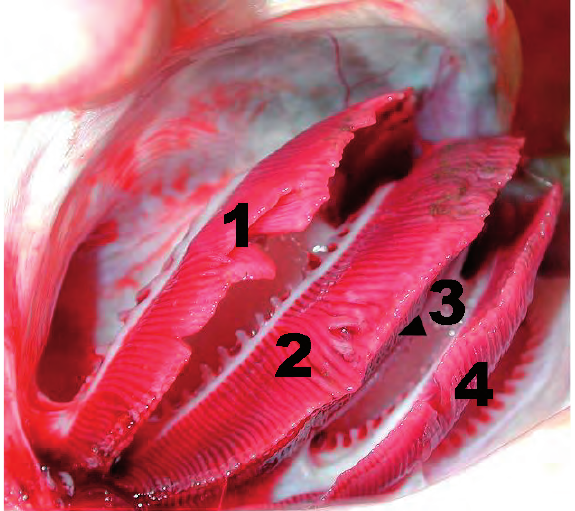
Gill arches of Labeobarbus polylepis in the gill cham- ber. Numbers indicate the gills’ position in succession from anterior to posterior